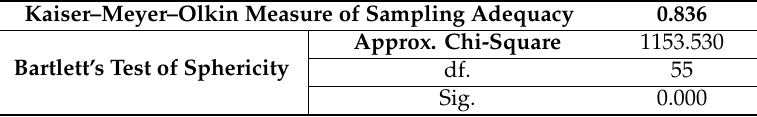
Table 6. Kaiser–Meyer–Olkin (KMO) and Bartlett’s Test (df: Degree of Freedom, Sig: